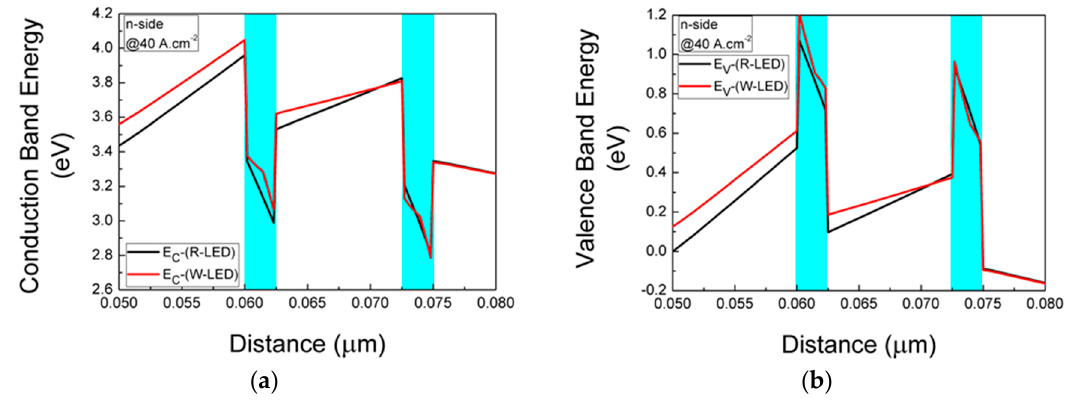
Figure 2. Comparison of band energy: ( a ) Conduction band energy; and, ( b ) Valence band energy.